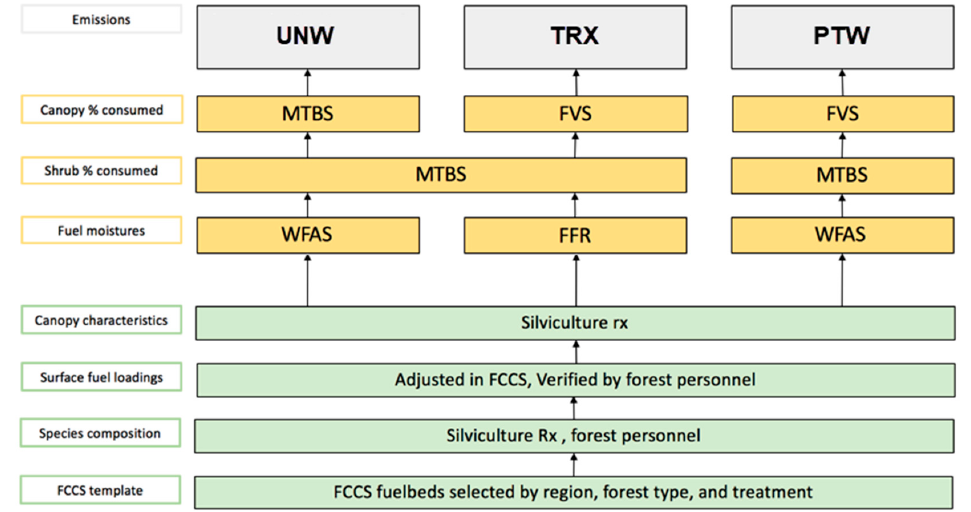
Figure 2. Our modeling approach with fuel representations shown in green, fuel moisture and canopy in yellow, and emission scenarios in gray. WFAS = Wildland Fire Assessment System, MTBS = Monitoring Trends in Burn Severity, FFR = Fire and Fuels Report [23]. Silviculture Rx = Silviculture prescription [22]. FVS = FVS-FFE runs were conducted by the forest in preparation of [23].